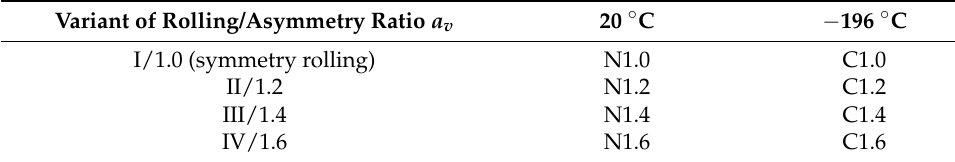
Table 2. Pass schedule of the rolling process. Variant of Rolling/Asymmetry Ratio a